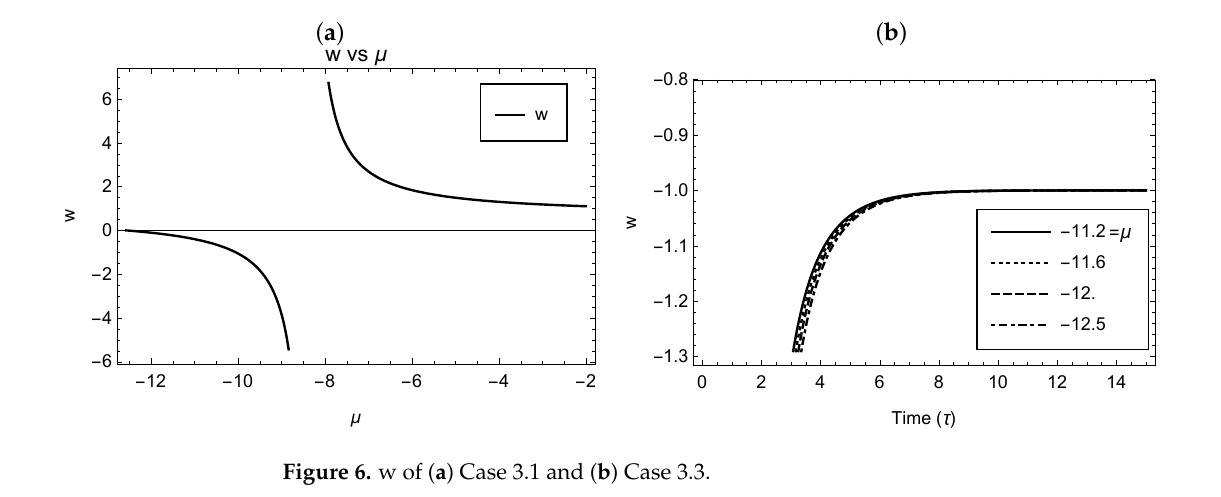
Figure 6. w of ( a ) Case 3.1 and ( b ) Case